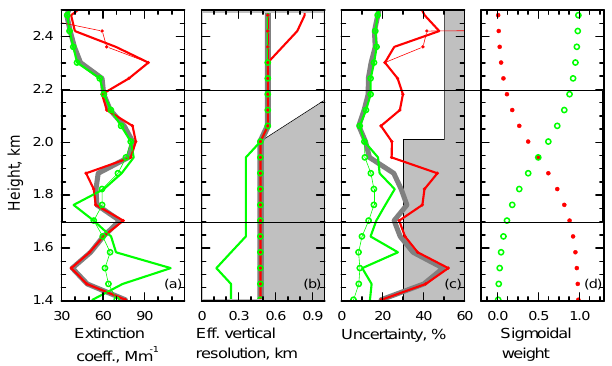
Figure 9. Illustration of the merging procedure. Presented are pro- files of particle extinction coefficients (a) with the corresponding effective vertical resolutions (b) and statistical uncertainties (c) as well as the profiles of the sigmoidal weighting factors (d) . Red and green curves are the original near-range and far-range profiles, re- spectively (step 1). Thin red and green curves with symbols corre- spond to profiles which were calculated with final vertical resolution (step 4). Red dots and green circles in panel (d) show the sigmoidal weighting factors of the near-range and far-range profiles, respec- tively. Bold gray profiles below the colored lines indicate the final results (step 5). Light gray areas illustrate the constraints of uncer- tainty and vertical resolution. Horizontal thin black lines indicate bottom and top of the merge